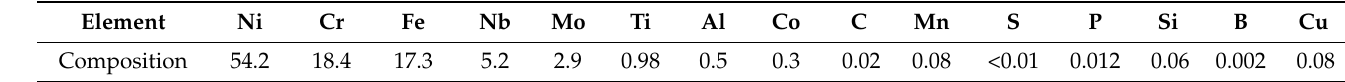
Figure 3. Sample and measurement setup. ( a ) Inconel 718 sample plate. ( b ) Ultra-Depth Three-Dimensional Microscope. Table 1. Chemical composition of Inconel 718 (wt %) [3].